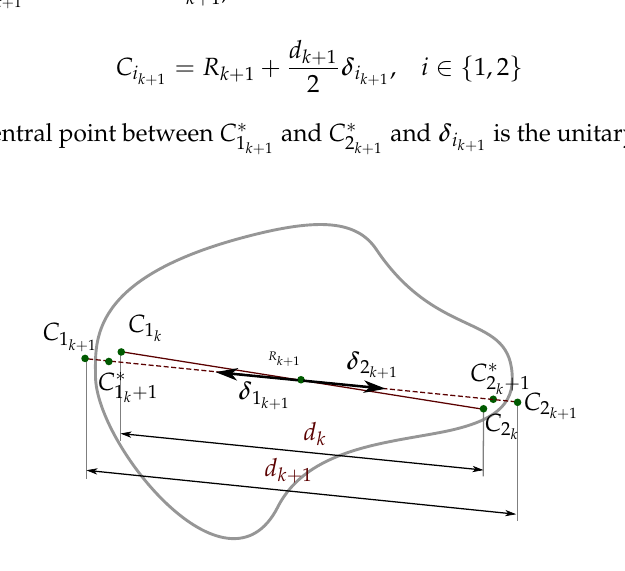
Figure 2. Example of the computation of C i contact force F k is larger than F max